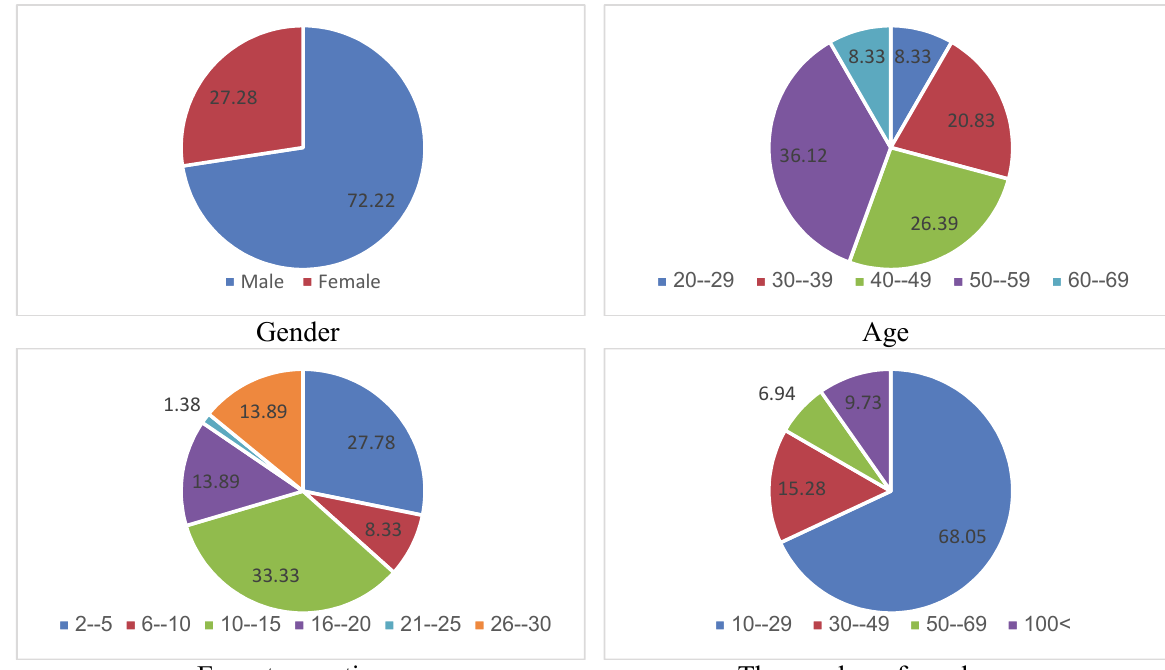
Fig. 1. Personal characteristics of the